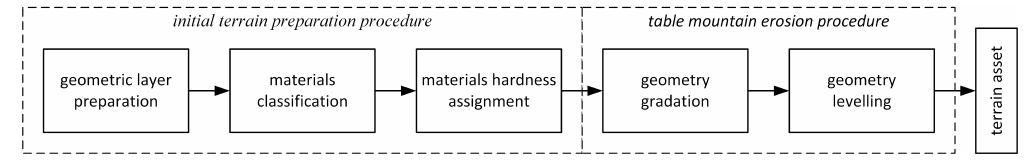
Figure 1. General schema of the proposed